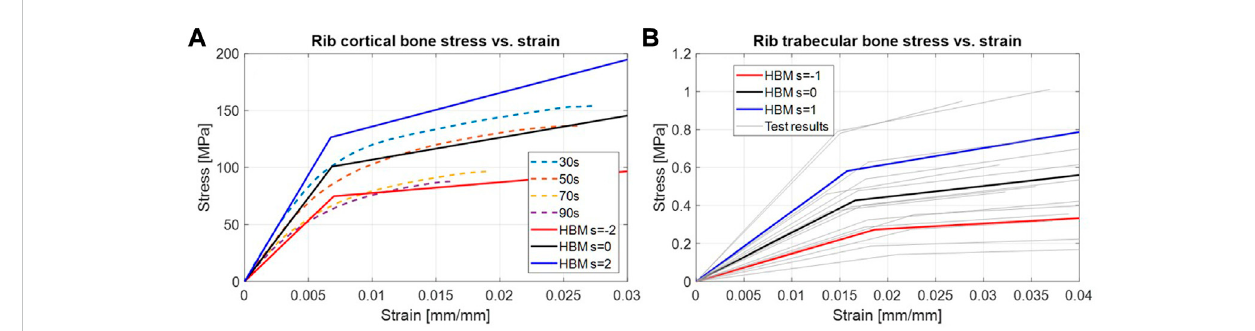
FIGURE 4 HBM lines represent the different values of the scaling coordinate used in the bi-linear material model. (A) : Rib cortical bone stress vs. strain. The range of 30 – 90s (dashed) is average responses for corresponding ages (Katzenberger et al., 2020). (B) : Rib trabecular bone stress vs. strain. Test results (gray lines) correspond to the material parameters from individual test results.